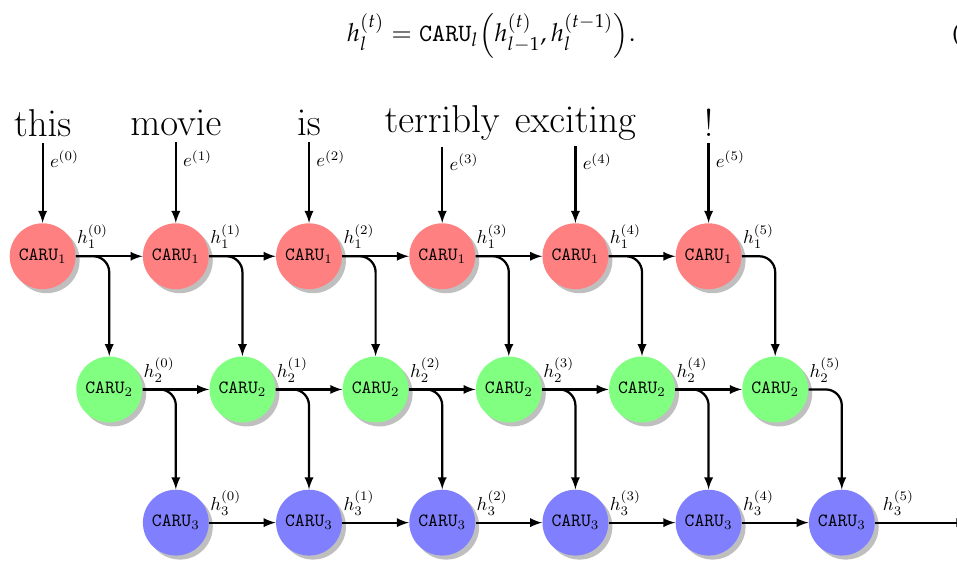
Figure 3. Three-level stacking implementation of multilayer